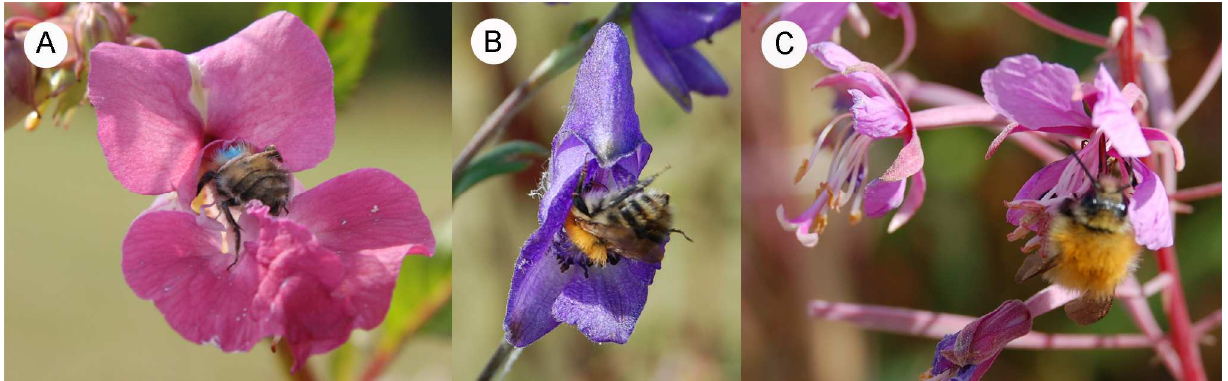
F IG . 1. Morphology of the three plant species and visiting behaviour of bumblebees ( Bombus pascuorum ). (A) When a bumblebee saps nectar from the spur of I. glandulifera , it touches anthers with dorsal parts (head, thorax and abdomen). Prior to insect visits, blue fluorescent dye had been deposited on open anthers of I. glandulifera and a dye load is visible on the back of the insect. (B) Bumblebee legitimately visiting A. napellus in search for nectar. When it enters the flower, dorsal parts touch anthers and stigmas. (C) Bumblebee drinking nectar on E. angustifolium . The ventral parts of the insect body are in contact with stigmatic lobes and